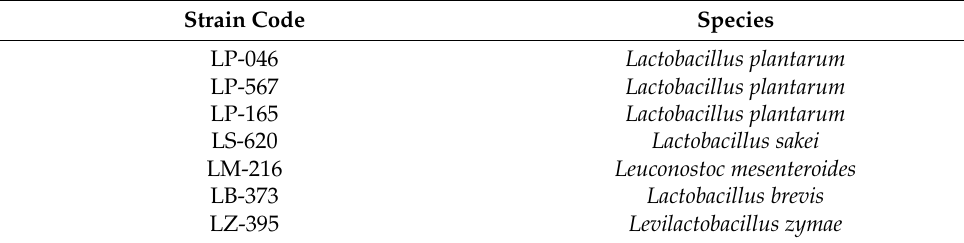
Table 1. The seven strains used in the